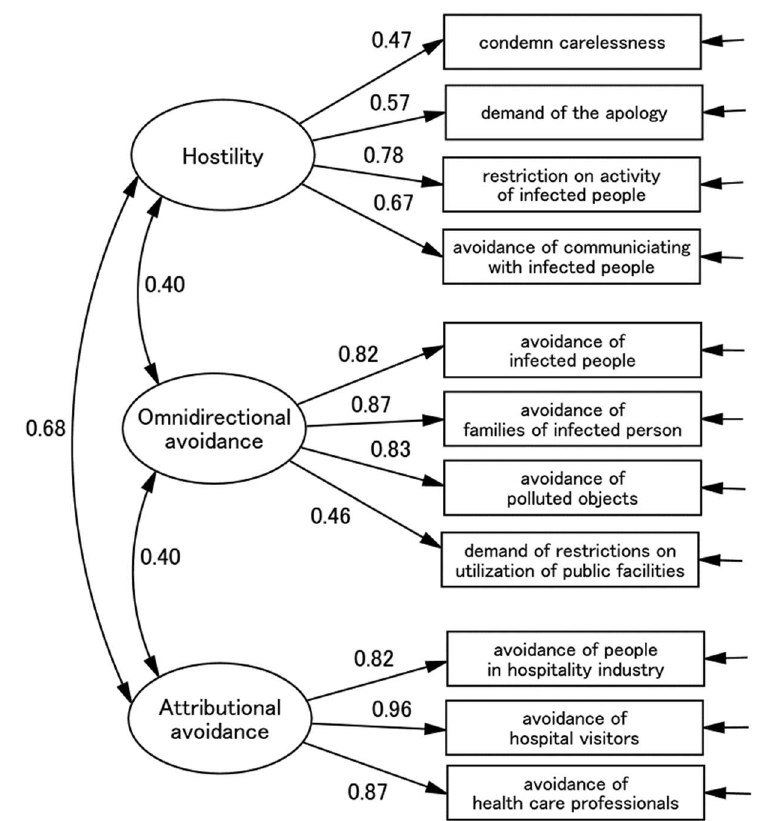
Figure 1. Confirmatory factor analysis of the scale items ( n = 346). CFI, comparative fit index; RMSEA, root mean square error of approximation; AIC, Akaike information criteria. Paths are standardised. The names of error variables are not shown.